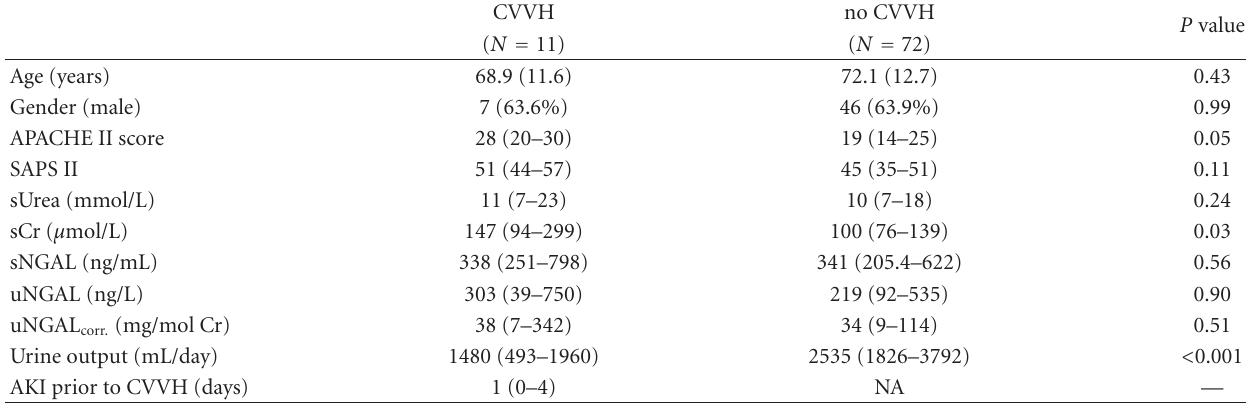
Table 2: Characteristics of acute kidney injury patients by presence or absence of CVVH.